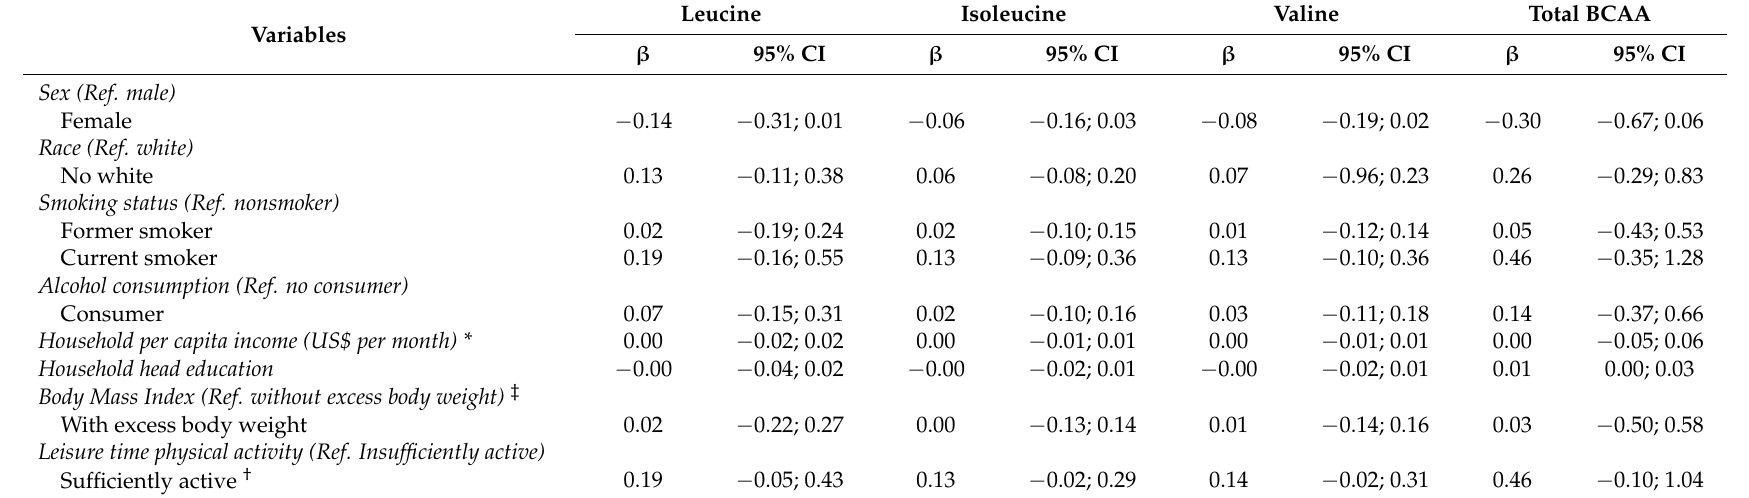
Table 3. Demographic, socioeconomic and lifestyle factors associated with branched chain amino acid intake in elderly adults, ISA Capital, S ã o Paulo, Brazil, 2008. Leucine Isoleucine Valine Total BCAA Variables β 95% CI β 95% CI β 95% CI β 95%